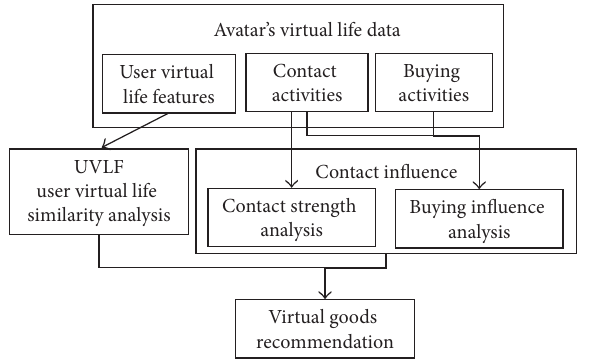
Figure 1: Overview of proposed